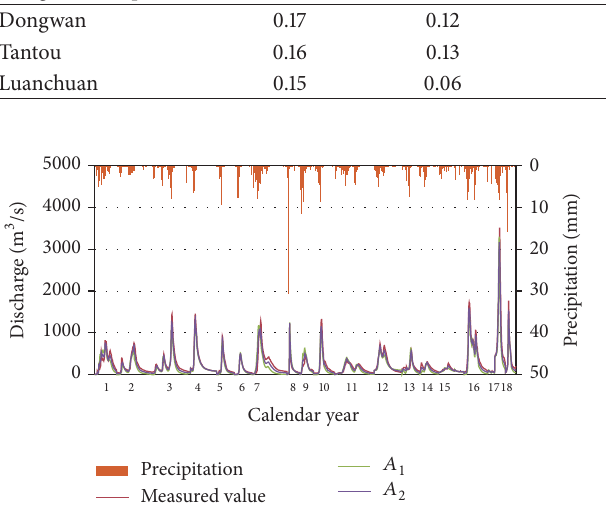
Figure 7: Comparison of the results of Dongwan.